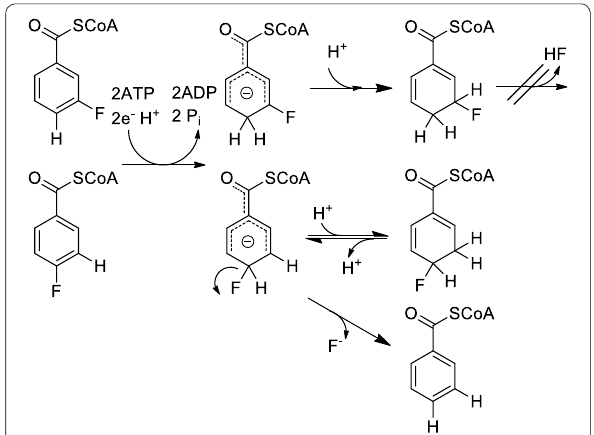
Fig. 2 Possible mechanism for reductive defluorination of BzCoA by ATP‑dependent class I